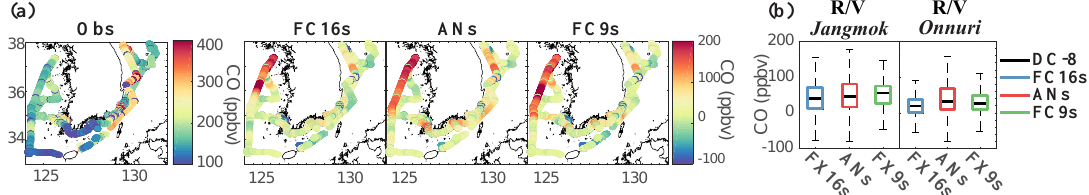
Figure 9. Comparisons of CAMS CO against ship measurements. Values of CAMS are averages across layers with pressure higher than 95% of the surface pressure. (a) Bias of CAMS CO against ship measurements along the ship track. (b) Box plot of CAMS bias for CO compared with ship measurements.